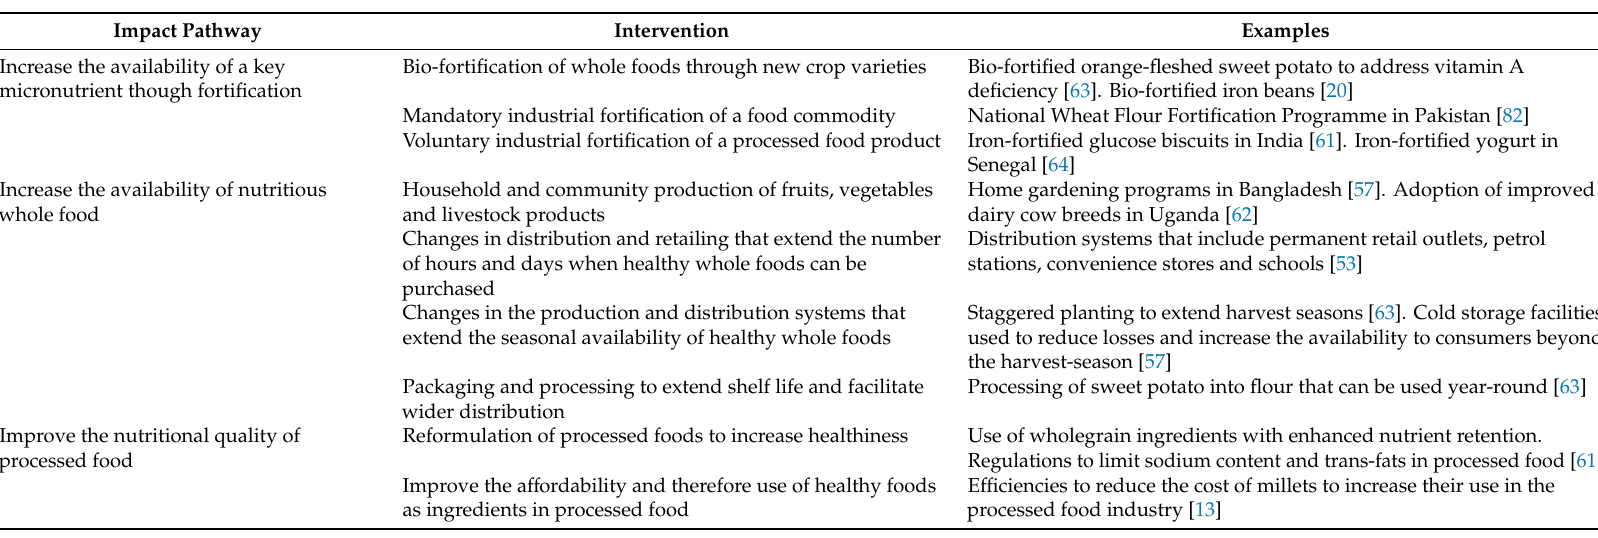
Table 2. Summary of value chain interventions with potential to improve diet quality through increasing the physical availability of nutritious food in the local food